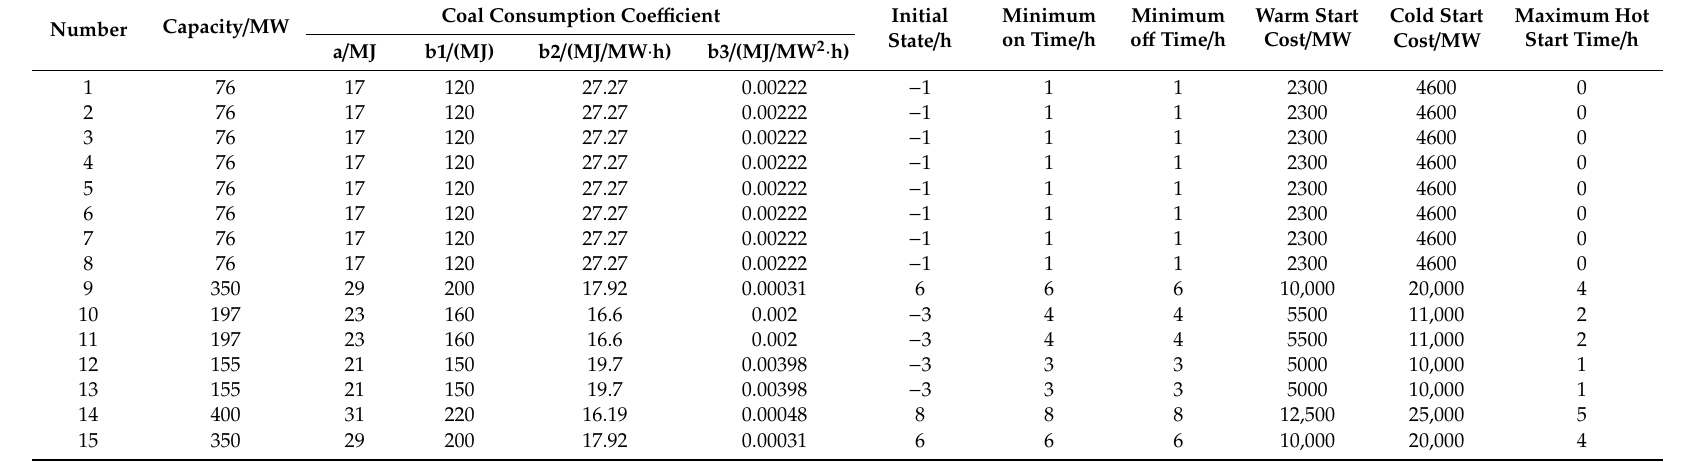
Table A2. Parameters of thermal